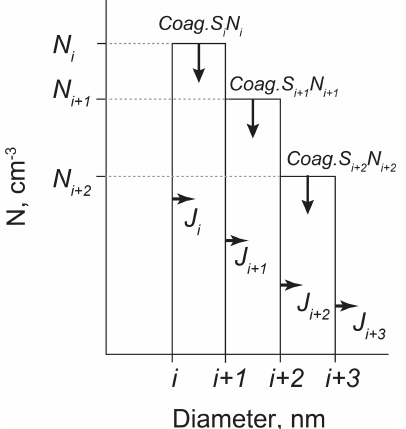
Figure 1. Schematic figure showing procedures used for the nucle- ation rate of aerosol particles with a size of D p = 5nm ( J 5 ). N i , Coag.S i , and J i , respectively, indicate the number concentrations, coagulation sink, and growth (or formation) rate for each size